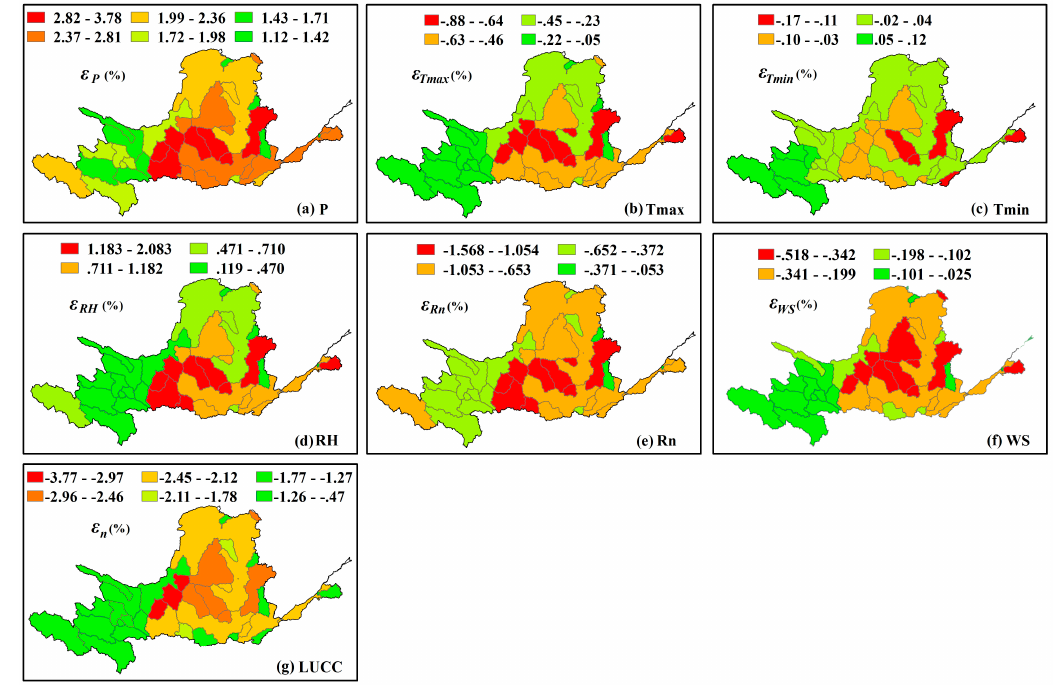
Figure 3. Elasticity of annual streamflow in terms of: annual precipitation ( a ); maximum air temperature ( b ); minimum air temperature ( c ); relative humidity ( d ); net solar radiation ( e ); wind speed ( f ), and landscape parameter n ( g ).